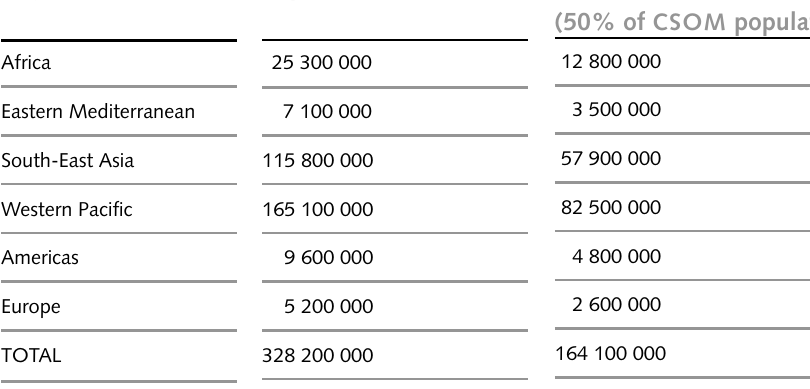
Table 6. Regional burden of CSOM and hearing impairment from CSOM , 1990